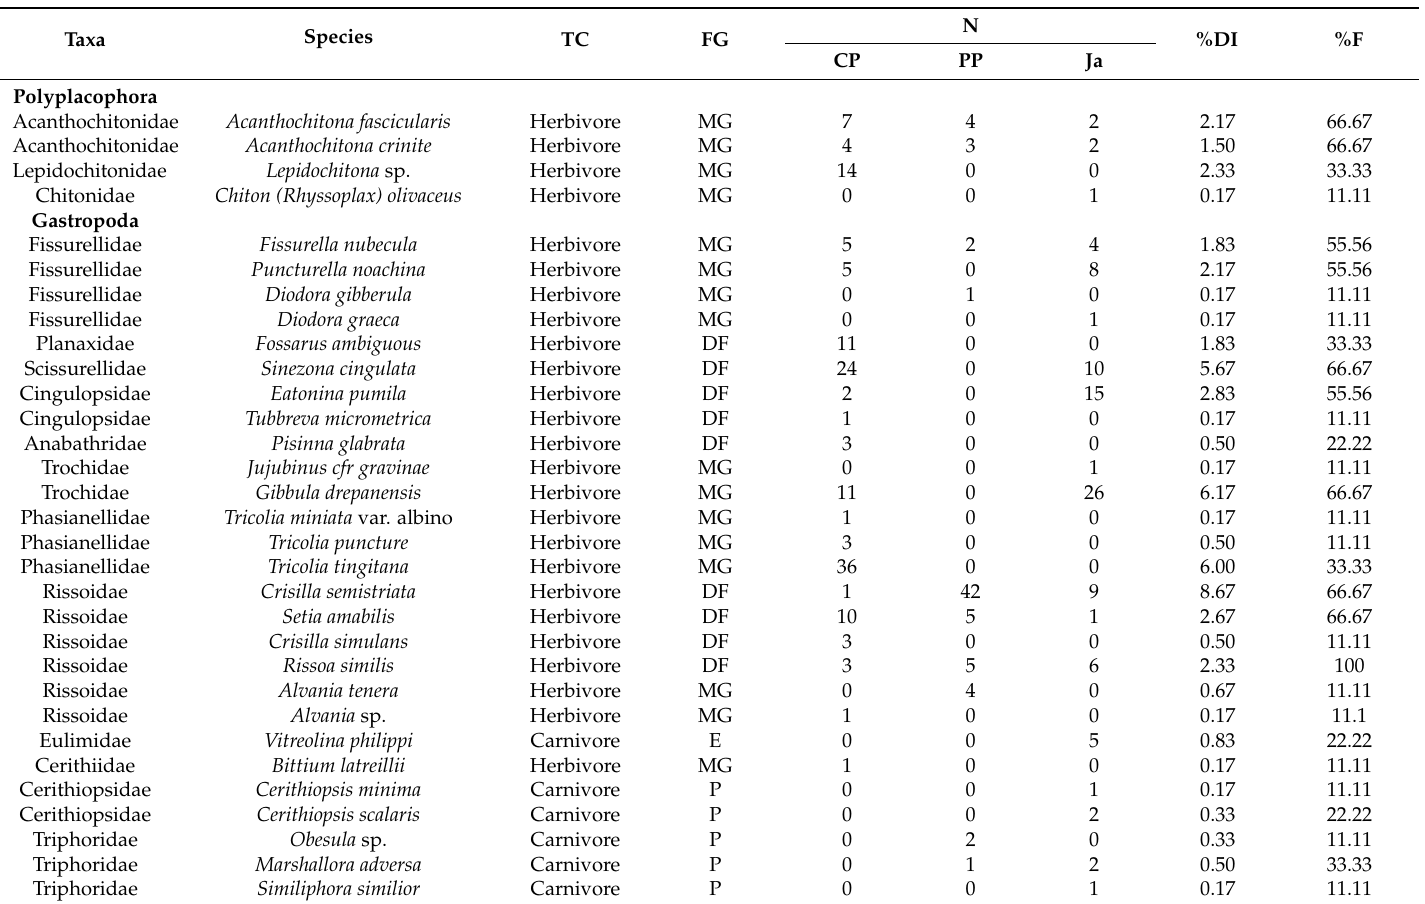
Table 2. Taxonomic list of mollusc species with their trophic categories (TC) and feeding guilds (FG: MG micro- and macro-grazers, DF deposit feeders, E ectoparasites, P predators, SF suspension feeders), their abundance (N) at each site (CP Cabo de Palos, PP Punta Prima and Ja J á vea), and their overall quantitative dominance (%DI) and frequency